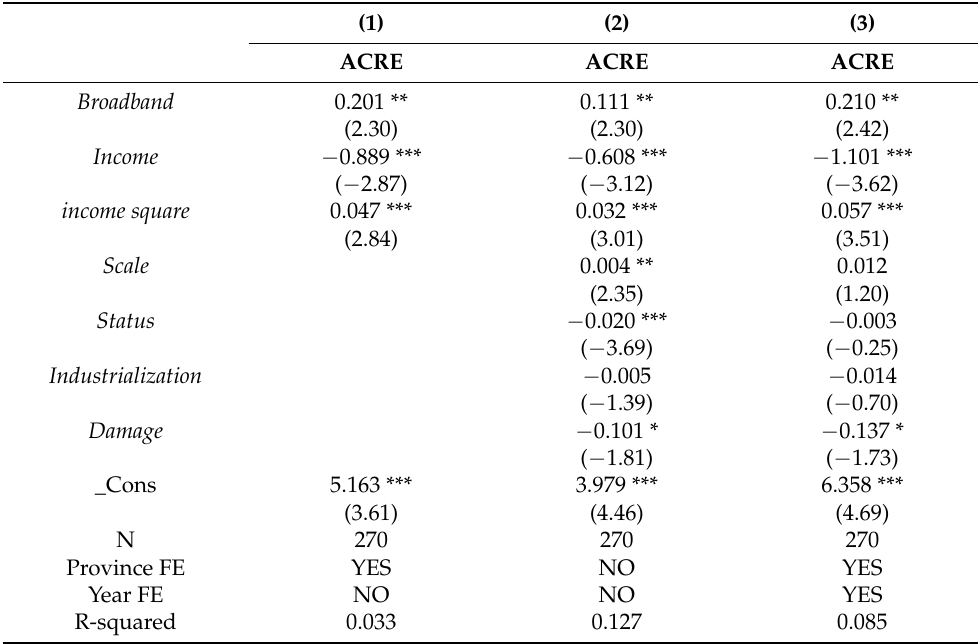
Table 4. Rural broadband adoption and agricultural carbon reduction efficiency.